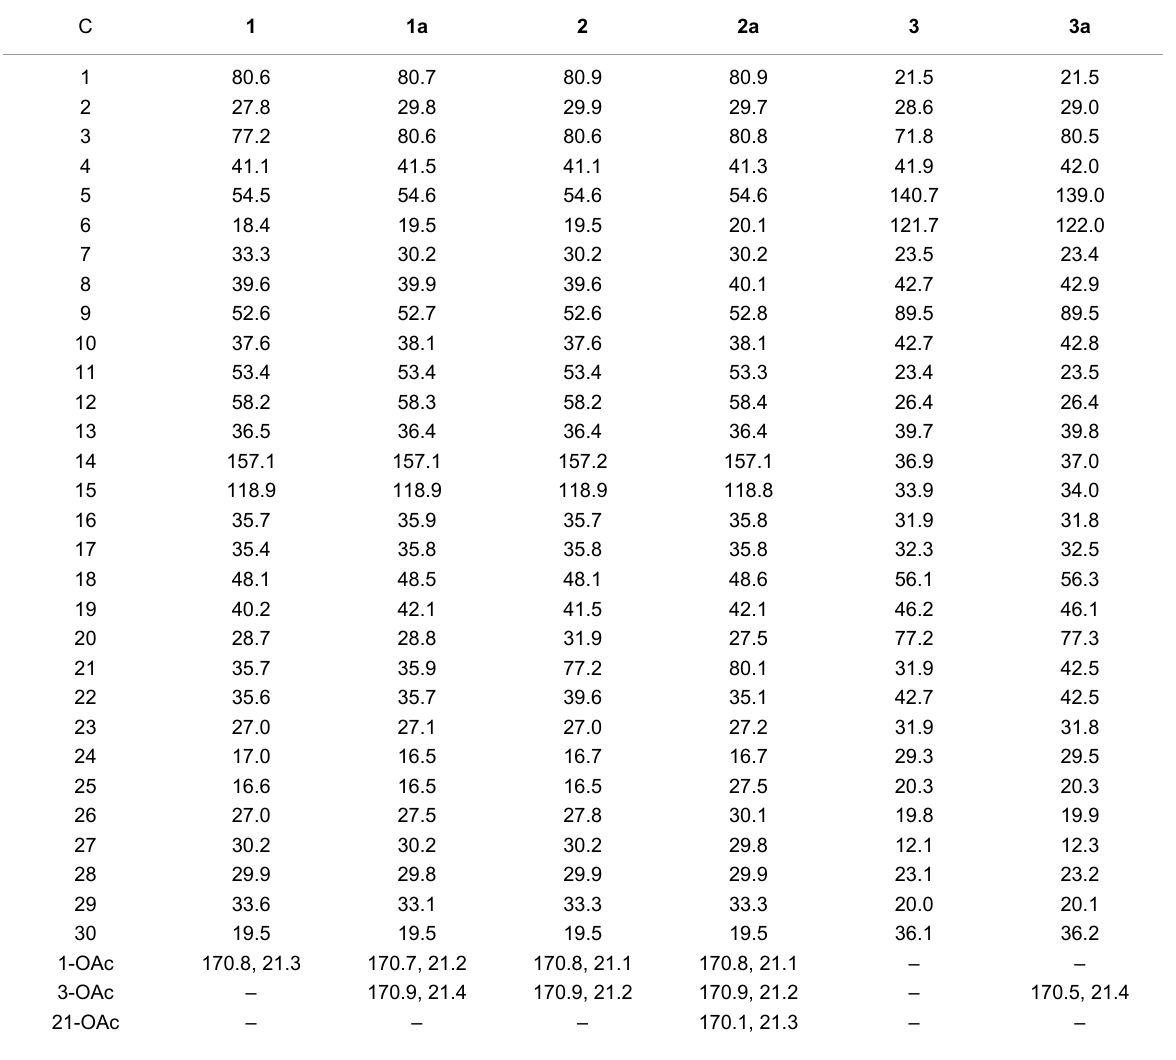
Table 1: 13 C NMR data of 1 , 2 , 3 and their acetates in CDCl 3 ( δ in ppm, 125